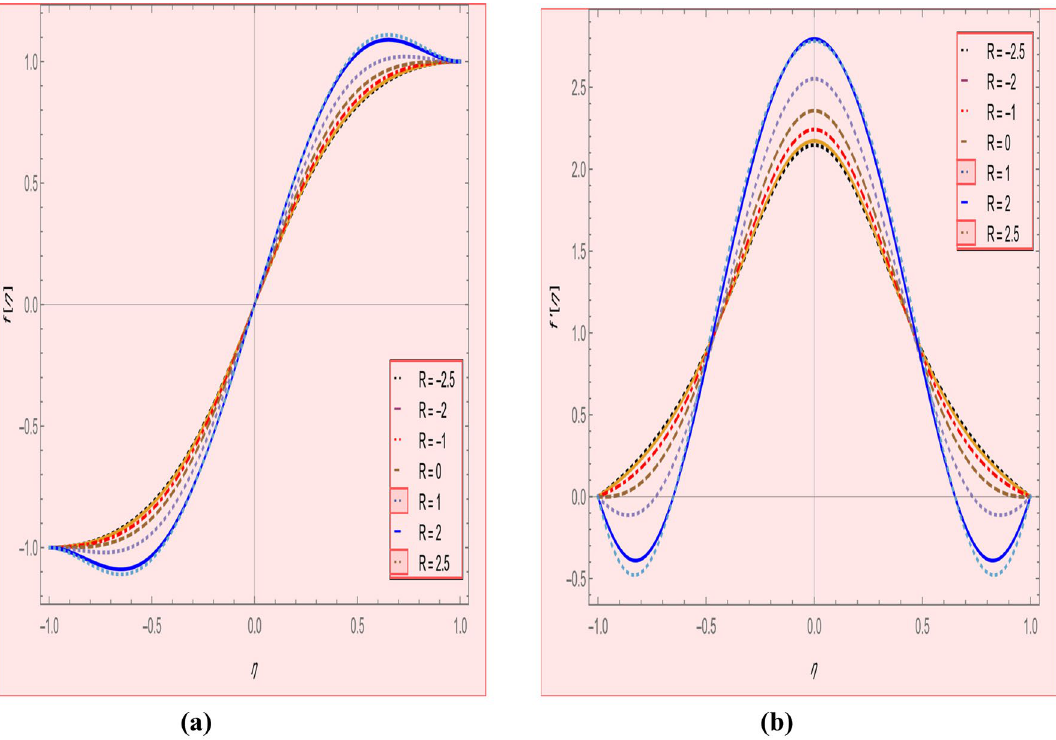
Figure 6. ( a ) Axial, ( b ) redial velocity profile effect in Reynold number for α = 5, ϕ 1 = ϕ 2 = 0.01, M = 1, SC = 1, Pr = 6.2 .